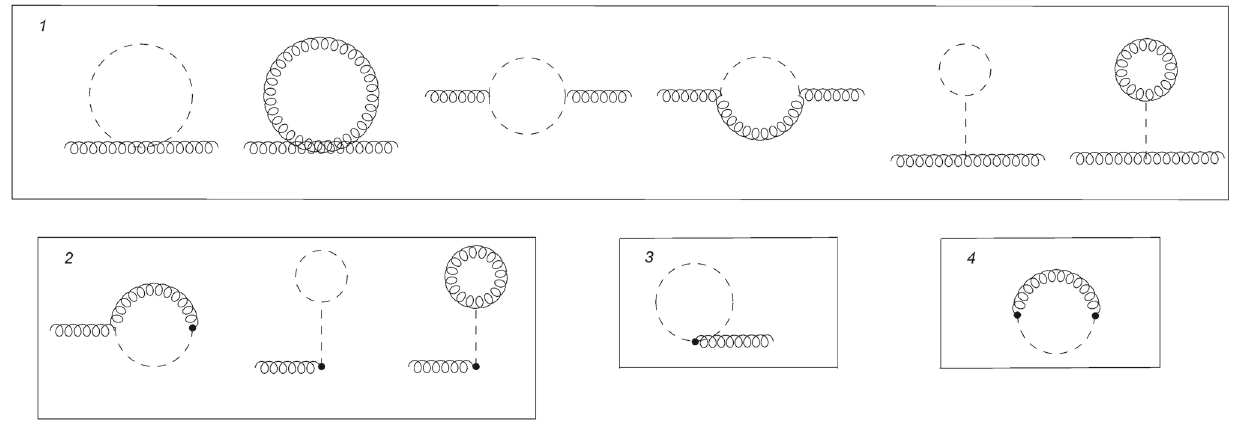
Fig. 14 One-loop contributions for the propagator (cid:2) O ( x ) O ( y ) (cid:3) in the unitary gauge. Curly lines represent the gauge field and dashed lines the Higgs field. The • indicates the insertion of a composite operator